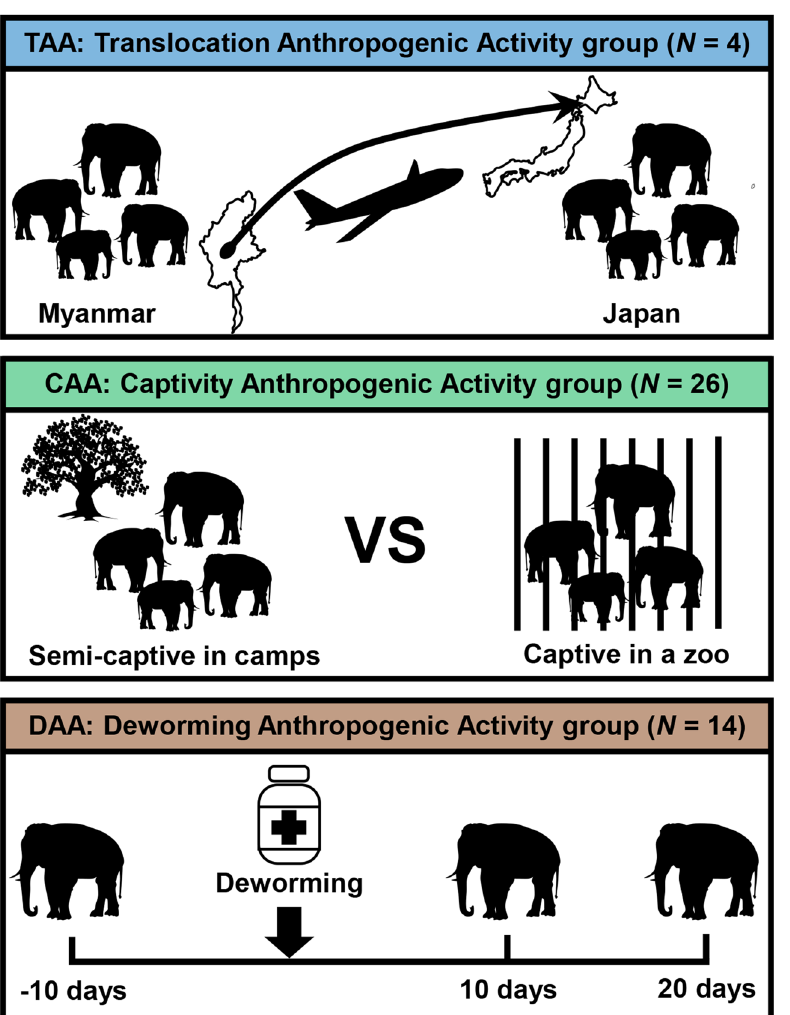
Figure 1. A diagram showing experimental design of each